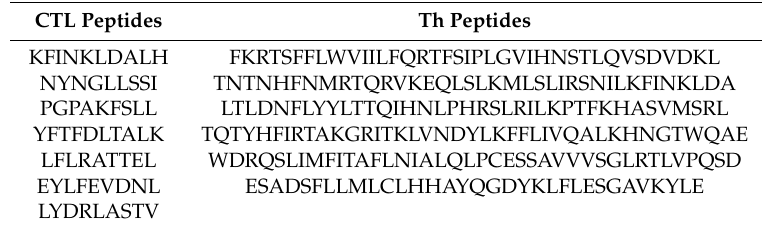
Table 1. Peptides used to stimulate immunized mice